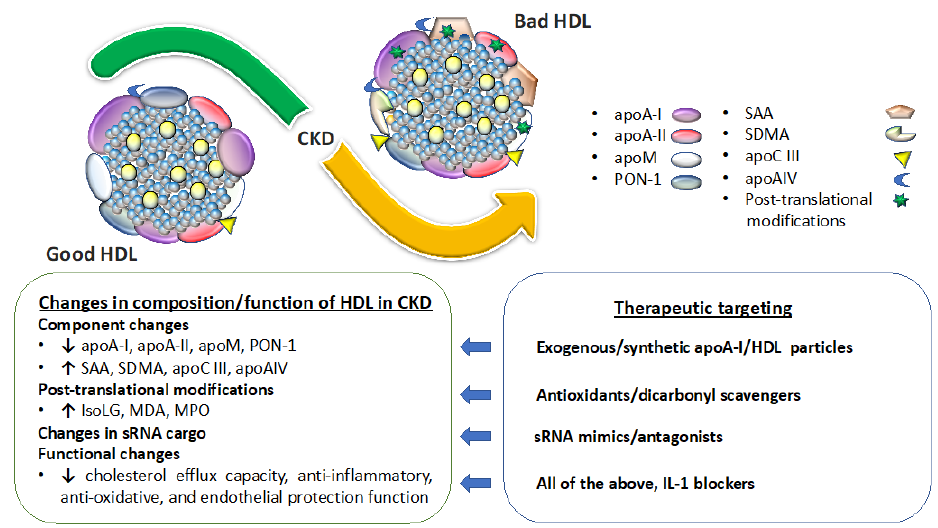
Figure 2. The effects of CKD on HDL structure and function, and the therapeutic implications.